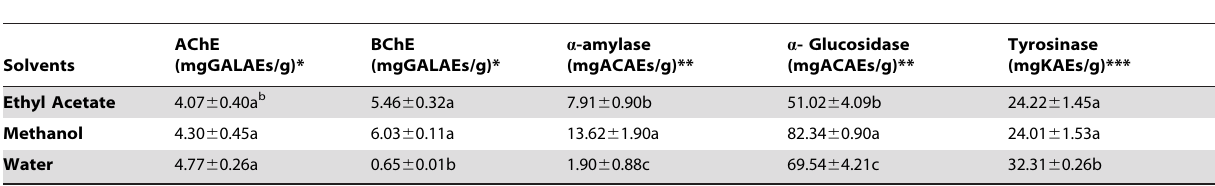
Table 3. Enzyme inhibitory activities of three extracts from Cotoneaster nummularia (mean 6 SD).